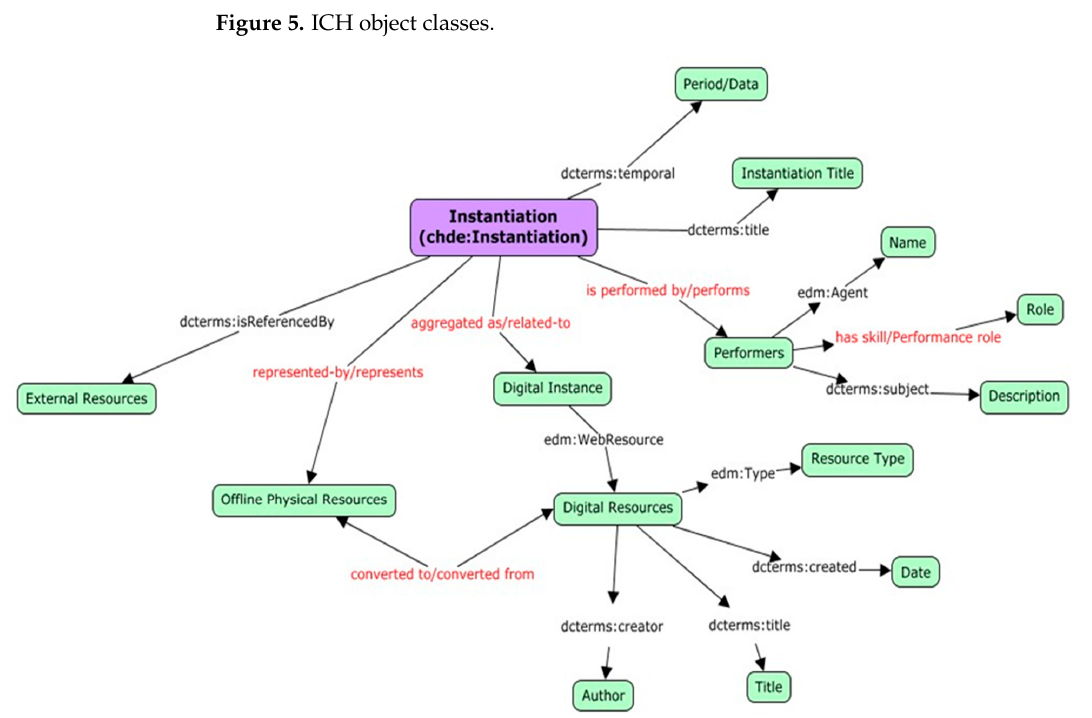
Figure 6. Instantiation classes.